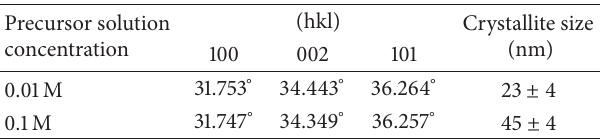
Table 1: Variation of crystallite size considering the three most intense diffraction peaks of synthesized ZnO nanoparticles at precursor concentration of 0.01 and 0.1 M,